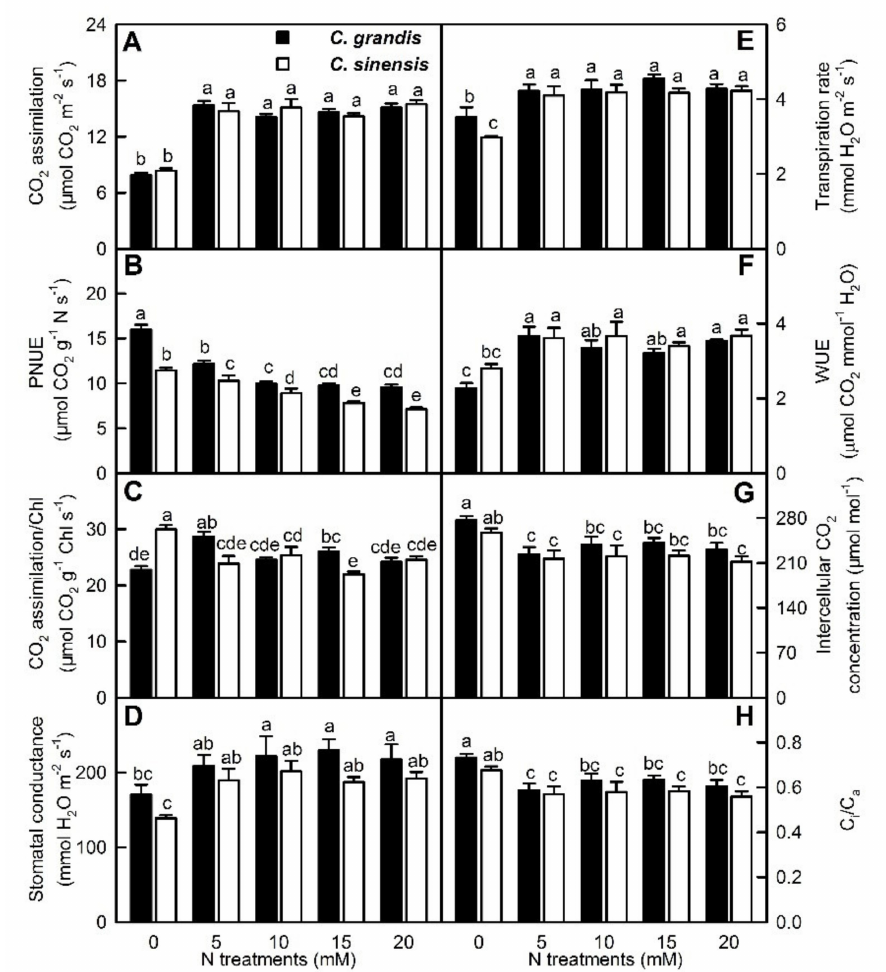
in C. sinensis leaves at 0 mM N, but it was lower in the latter at 5 and 15 mM N (Figure 6).